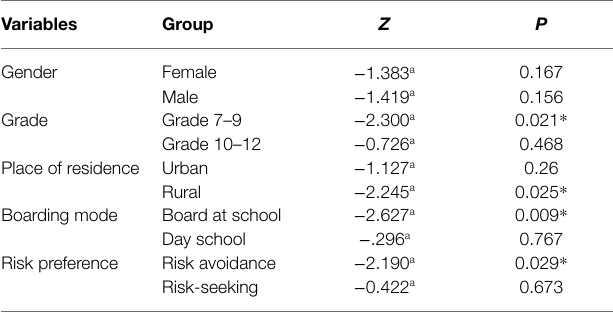
TABLE 5 | Influence of risk preference on choice of textual features.